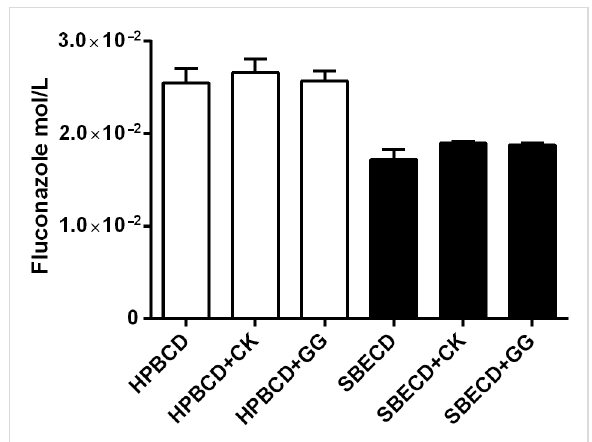
Figure 2: Solubility of fluconazole in aqueous solutions containing 5% of CD and 0.5% of the respective